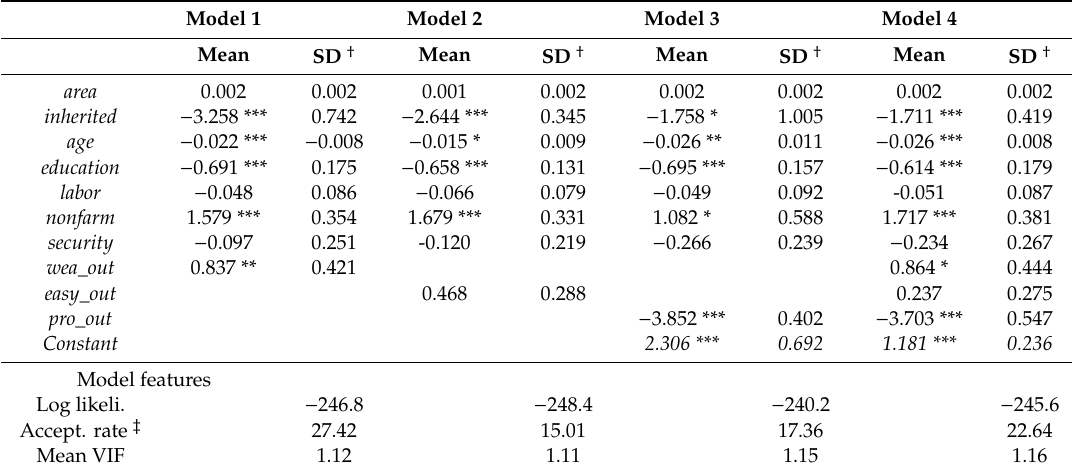
Table 4. Results of factors a ff ecting farmers’ intention of leasing out